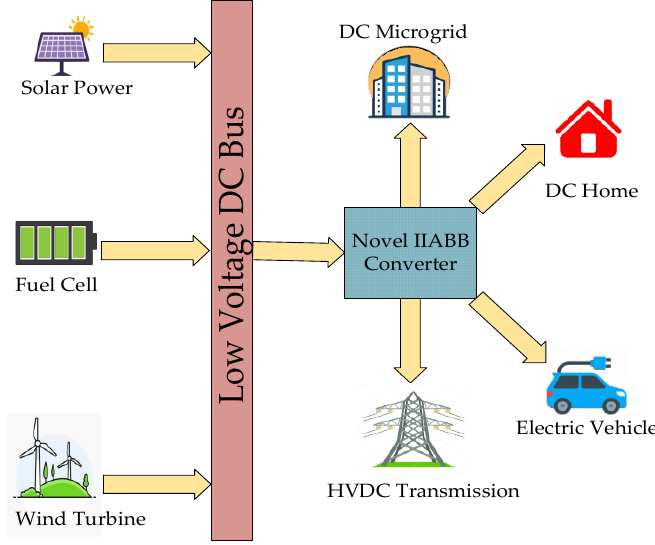
Figure 1. Various applications of the novel IIABB converter.